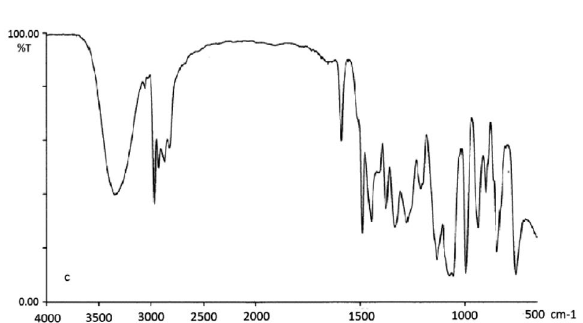
Figure 1. IR spectra of phenylene-1,2-diamine (a), benzene-1,2-di- amine- N , N , N ’, N ’-tetraethane-2,2’,2’’,2’’’-tetraol (modifier A)